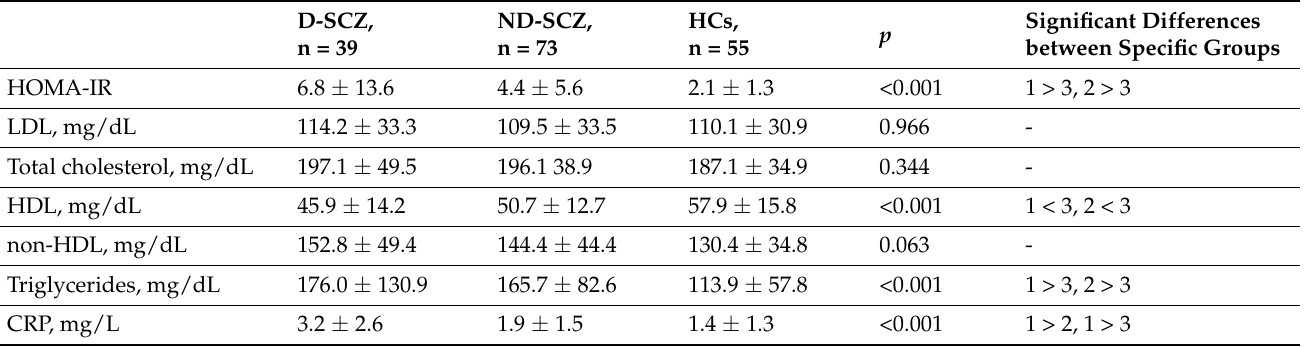
Table 2. Between-group differences in biochemical parameters.